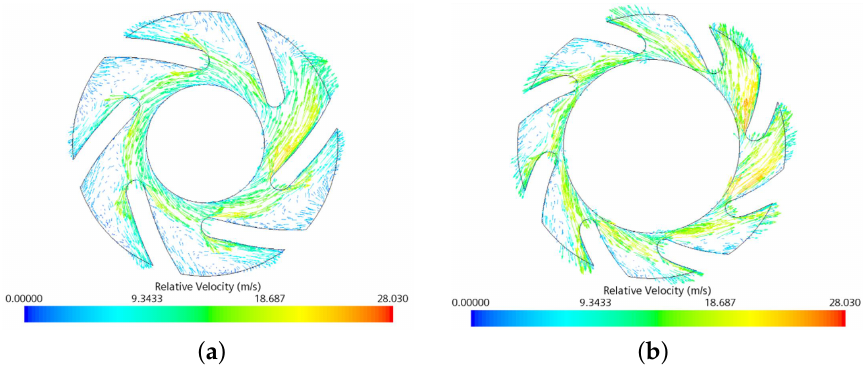
Figure 14. Volute field over the impeller: ( a ) proposed method; ( b ) Stepanoff method.